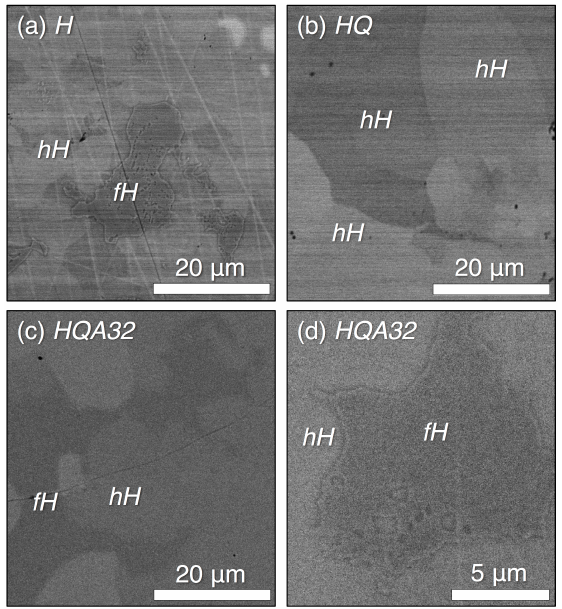
Figure 5. BSE SEM micrographs show the orientation and phase contrast in samples ( a ) H , ( b ) HQ and ( c , d ) HQA32 , enabling analysis of microstructure evolution. (a) The homogenized sample contains separate TiNiSn and TiNi 2 Sn regions; (b) after quenching from a high temperature, we do not observe the Heusler phase, but homogeneous half-Heusler, which according to EDS, contains excess Ni; ( c ) low temperature annealing reintroduces the Heusler phase, as detailed in (d).